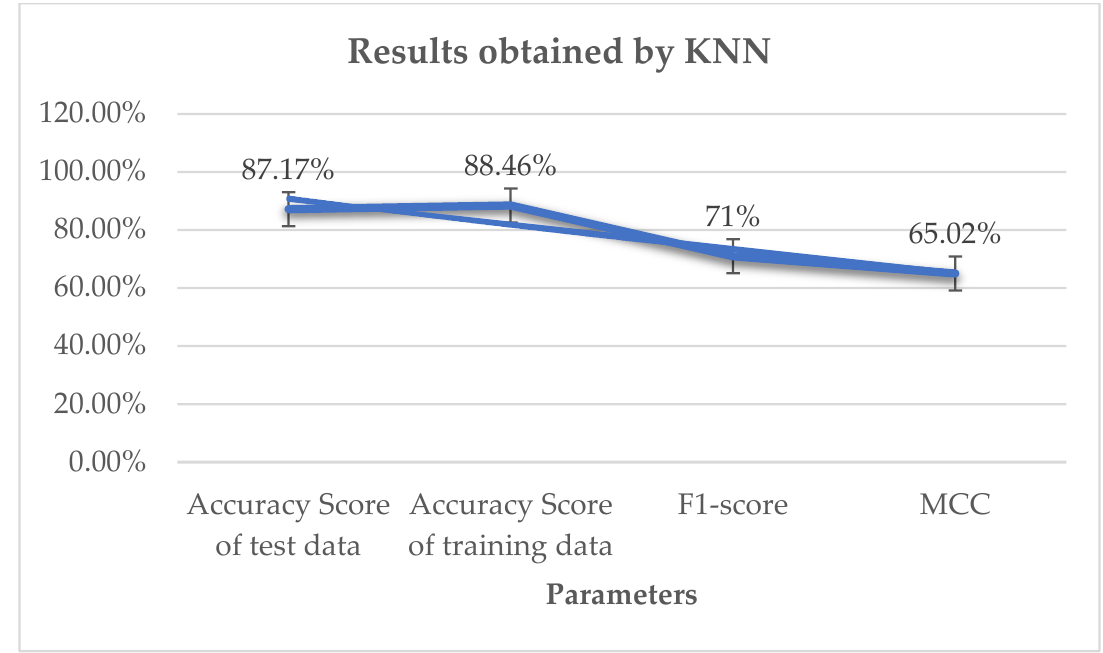
Figure 9. Results obtained by KNN.